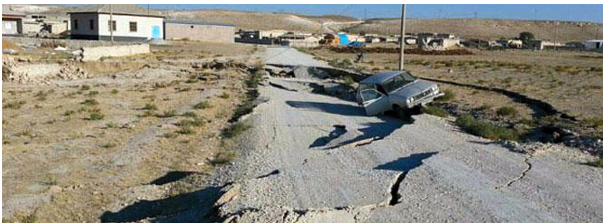
Figure 1. An earth fissure caused by land subsidence in the south- western part of the